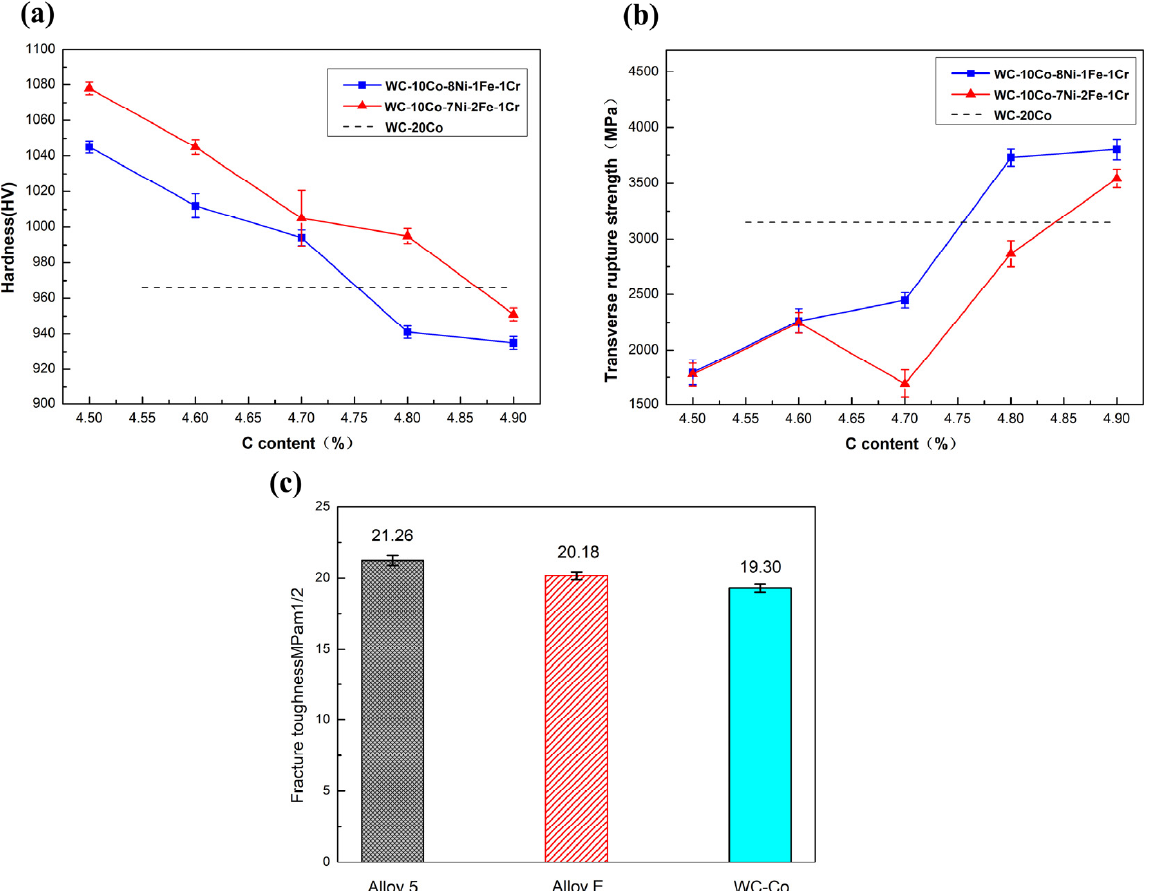
Figure 5. Mechanical properties of WC ‐ CoNiFeCr and WC ‐ Co cemented carbides as a function of the carbon content: ( a ) hardness and ( b ) TRS; ( c ) fracture toughness of Alloy 5, Alloy E and WC ‐ Co.